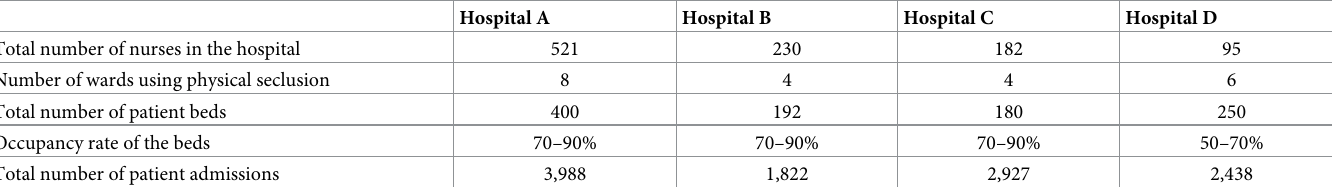
Table 1. Hospital characteristics (April